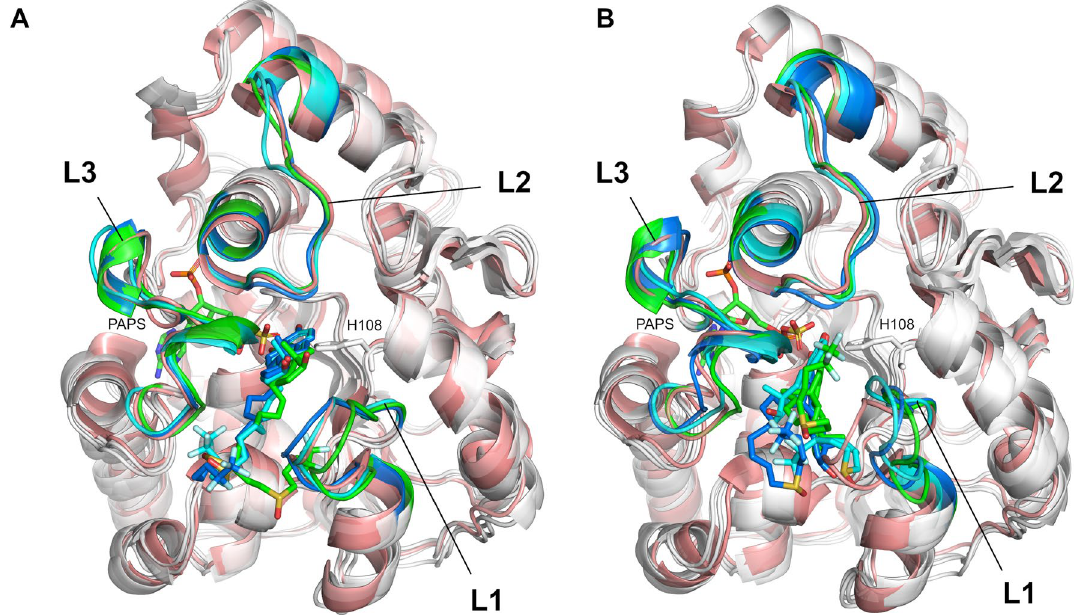
Figure 8. Favorable docking positions of fulvestrant in ( A ) three MD and ( B ) three MDeNM generated conformations. The apo crystal structure of SULT1A1*1 (4GRA.pdb) is shown in salmon for